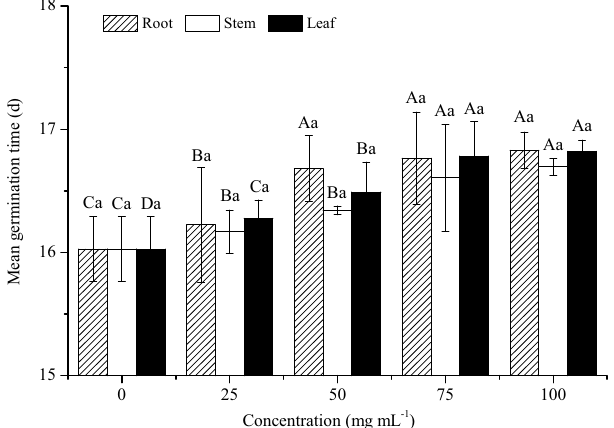
Figure 1. Effects of different aqueous extracts of sesame on the mean germination time. Different capital letters of the same organ indicated significant differences among different concentrations at P < 0.05 level, and different lowercase letters of the same concentrations indicated significant differences among different organs at P < 0.05 level.